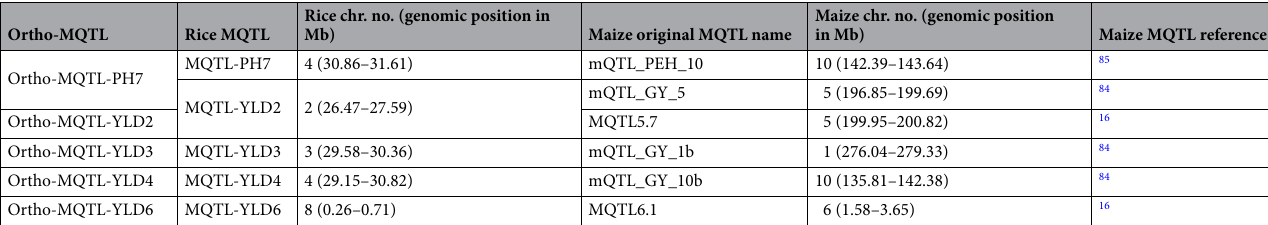
(Table 3). Interestingly, MQTL-YLD4 for YLD under water deficit conditions on chromosome 4 overlapped with MQTL-RDR2 and RL1 (Fig. 2). Overlapping MQTLs for different root architecture traits included MQTL-RDW1 and MQTL-RT2 on chro- mosome 1, MQTL-RDW2 and MQTL-RN2 on chromosome 5 and MQTL-RN1 and MQTL-RT1 on chromosome